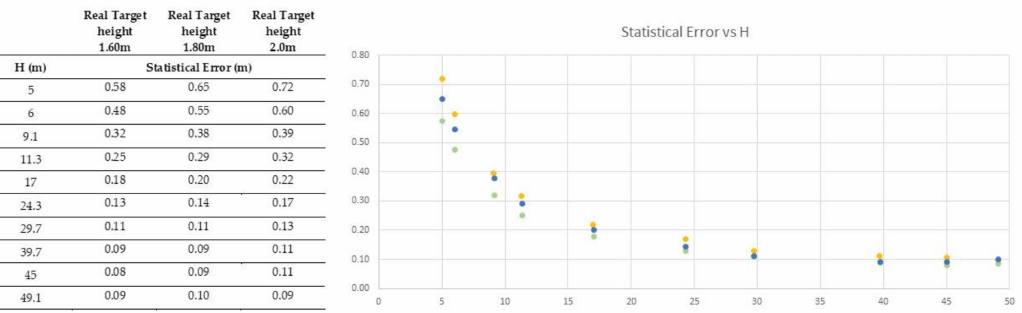
Figure 10. Statistical error calculated for a target of 1.60 m, 180 m and 2.0 m for ten di ff erent horizontal camera-to-target distances (on the right). Statistical error plotted against the horizontal camera-to-target distances (on the left, green circles: target height = 1.60, blue circles: target height = 1.80 m, yellow circles: target height = 2.0